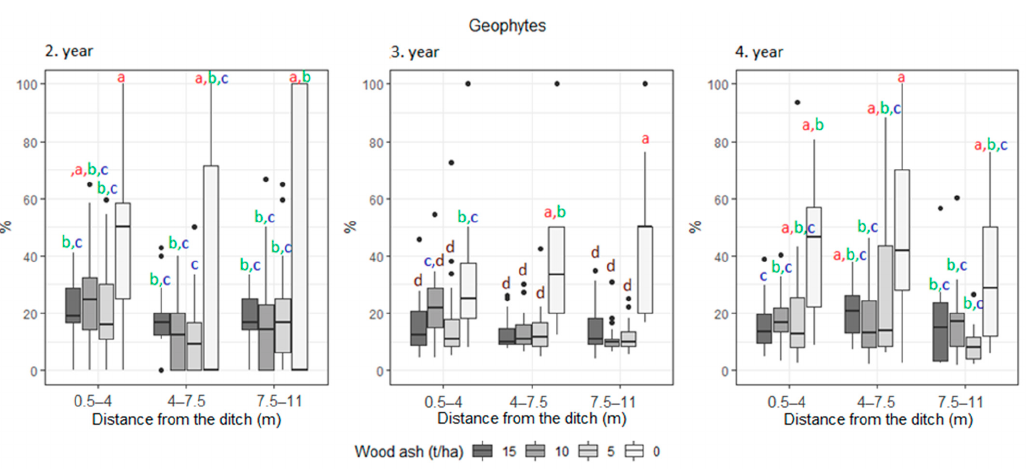
Figure A1 . Relative cover of plants with geophyte growth form of the total vegetation cover, depending on the distance from the drainage ditch and the dose of wood-ash fertiliser. Different letters (a, b, c, d) indicate significant differences between groups, p < 0.05 according to the Tukey HSD test.